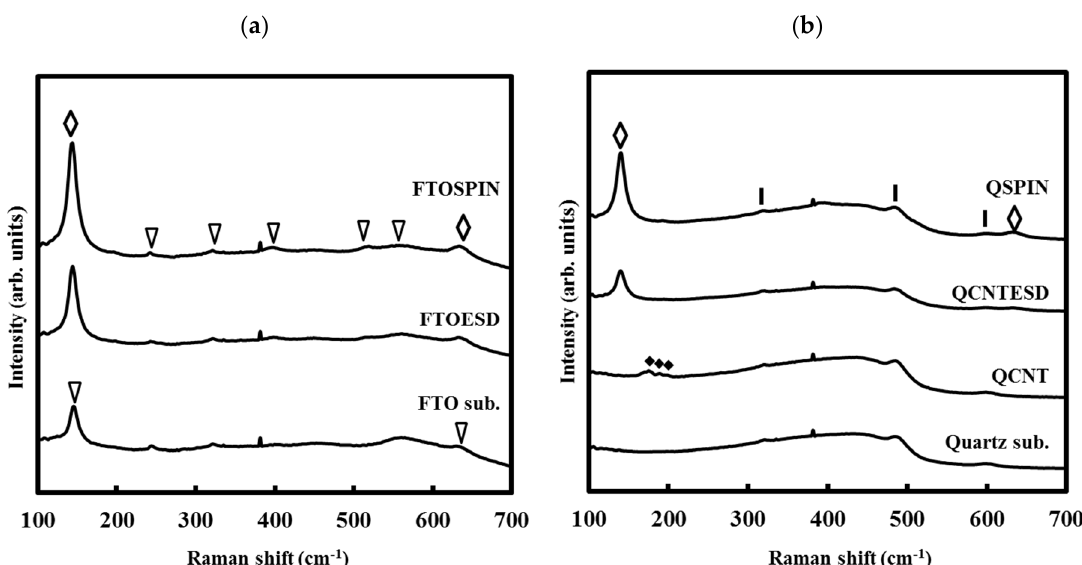
Figure 6. Raman spectra of the titania thin films on two different substrates, along with that of each substrate: ( a ) FTO-precoated glass substrate, FTOESD, and FTOSPIN, where the symbols represent anatase (◊) and FTO (∙); ( b ) quartz glass substrate, QCNT, QCNTESD, and QSPIN, where the symbols represent anatase ( ◊ ), Radial breathing mode (RBM) ( ♦ ) of SWCNT, and quartz glass substrate (|).